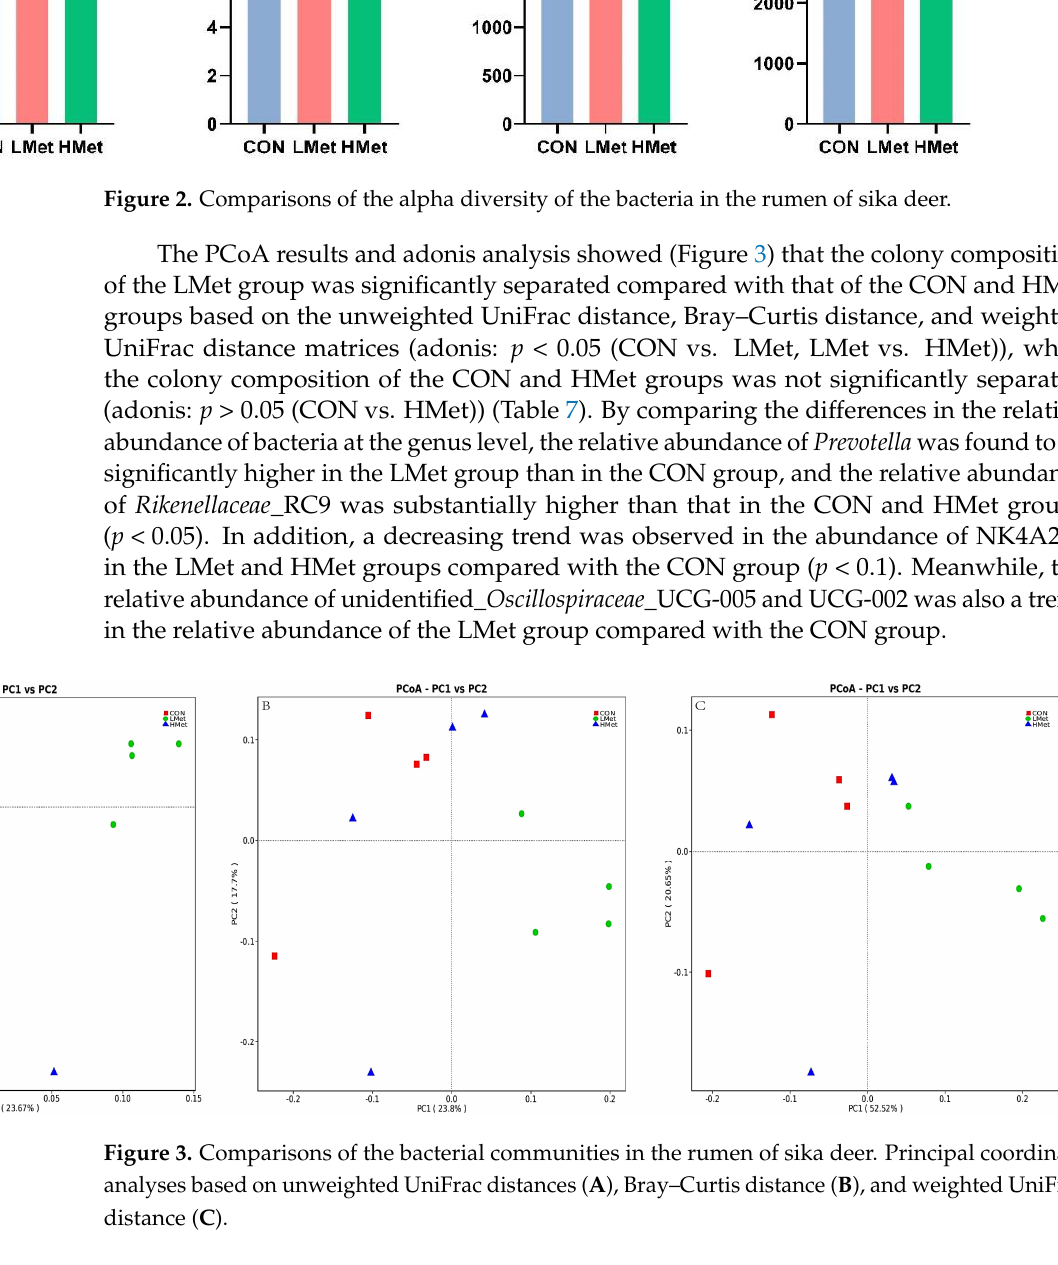
Figure 1. Bacterial composition in the rumen of sika deer at the phylum ( A ) and genus ( B ) levels.